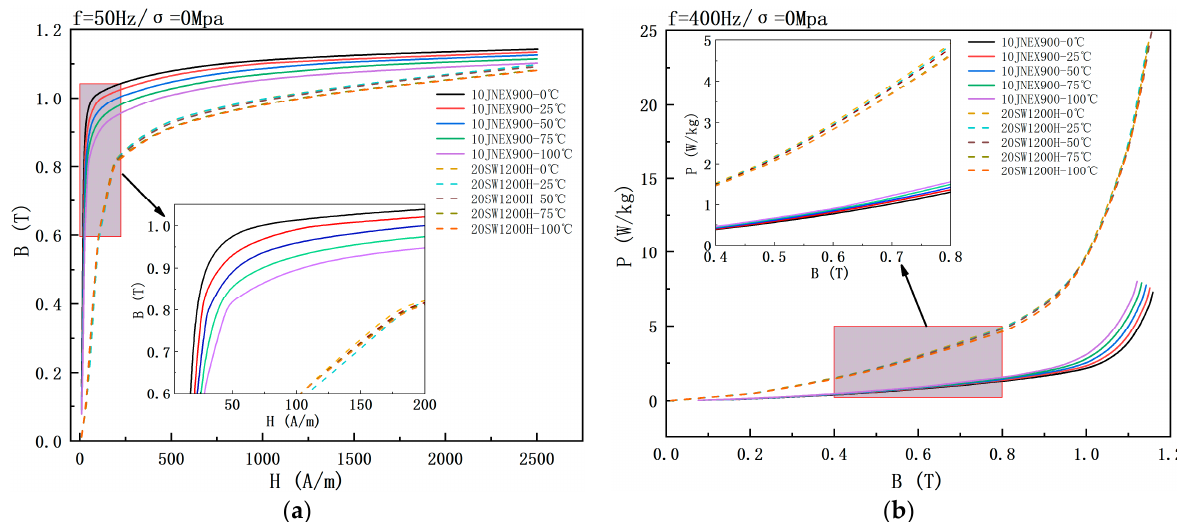
Figure 5. Effect of temperature on magnetic properties of two silicon steels at 0 Mpa. ( a ) B-H curve. ( b ) B-P curve.